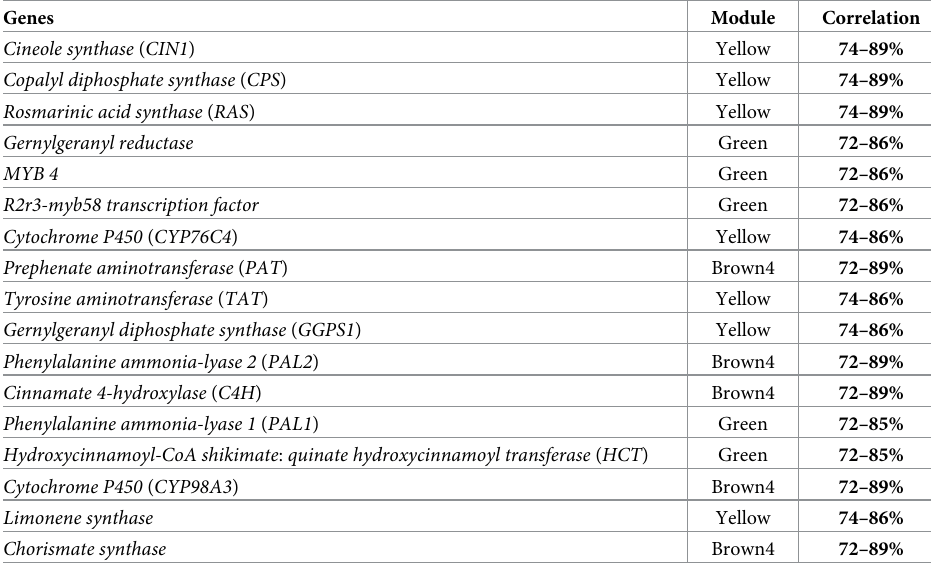
Table 6. The identified hub genes in correlation with rosmarinic and carnosic acid